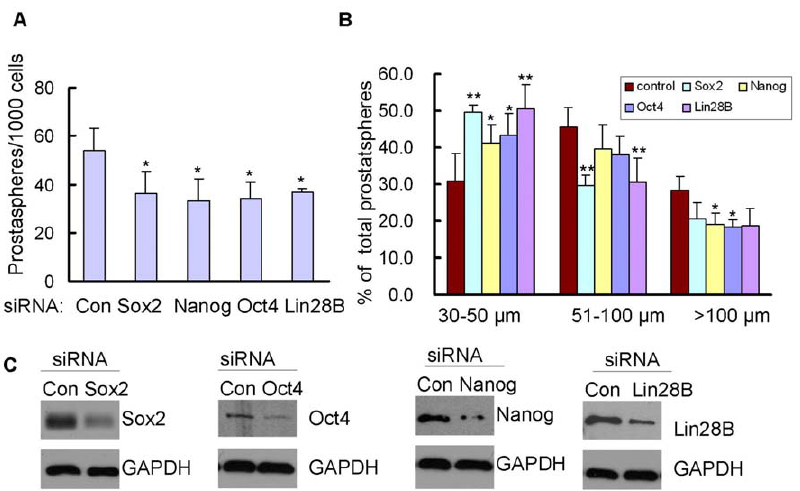
Figure 7. Sox2, Nanog, Oct4 and Lin28B regulated Prostasphere-forming ability of PC3 PDGF-D cells. (A) Single cell suspensions of PC3 PDGF-D transfected with Sox2, Nanog, Oct4 and Lin28B siRNA and incubated for 24 h were plated on ultra low adherent wells of 6-well plate at 2000 cells/well. After 3 days, the numbers of prostaspheres were counted under microscope. Transfection of Sox2, Nanog, Oct4 or Lin28B siRNA reduced the prostasphere-forming capacity (B) Prostaspheres were photographed and the size of prostaspheres in diameter was measured using software image analysis program Scion Image. (C). Western blot analysis showed that levels of Sox2, Nanog, Oct4 and Lin28B in PC3 PDGF-D cells transfected with Sox2, Nanog, Oct4 and Lin28B siRNA compared with transfection with control siRNA (*, p , 0.05, **, p , 0.01 compared to control, Con: control).